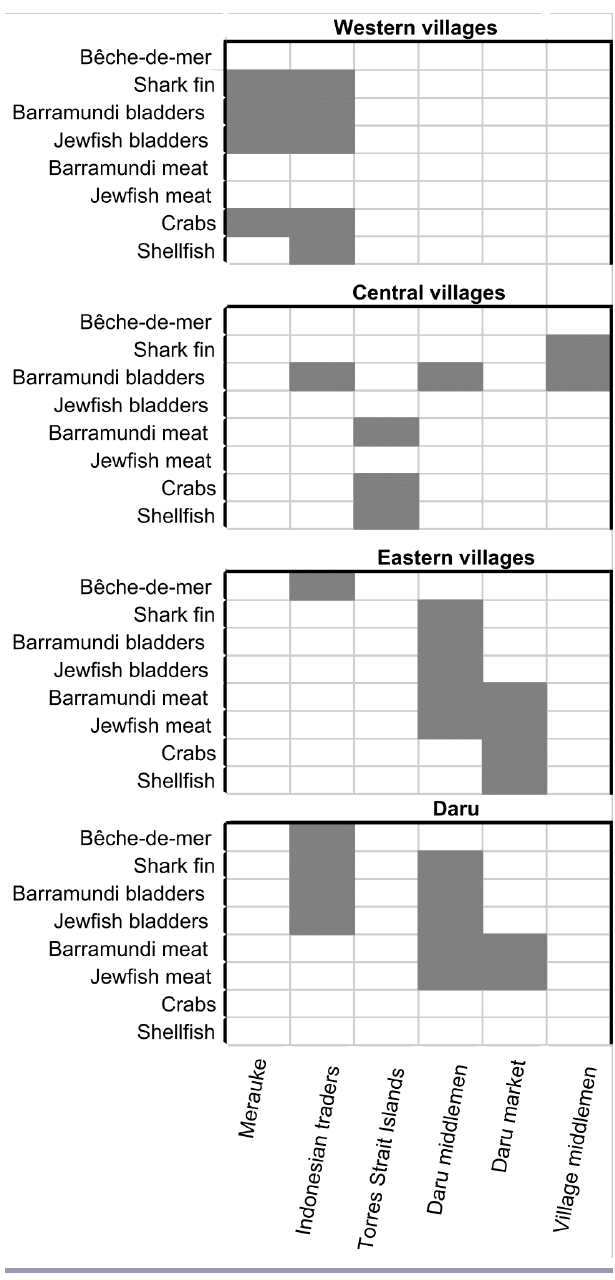
Fig. 5 . Marine products that are harvested and/or traded with the Indonesian buyers and Torres Strait Islanders, listed in descending order of value. Both illegal and legal markets or points of sale for western, central villages, eastern villages, and Daru are